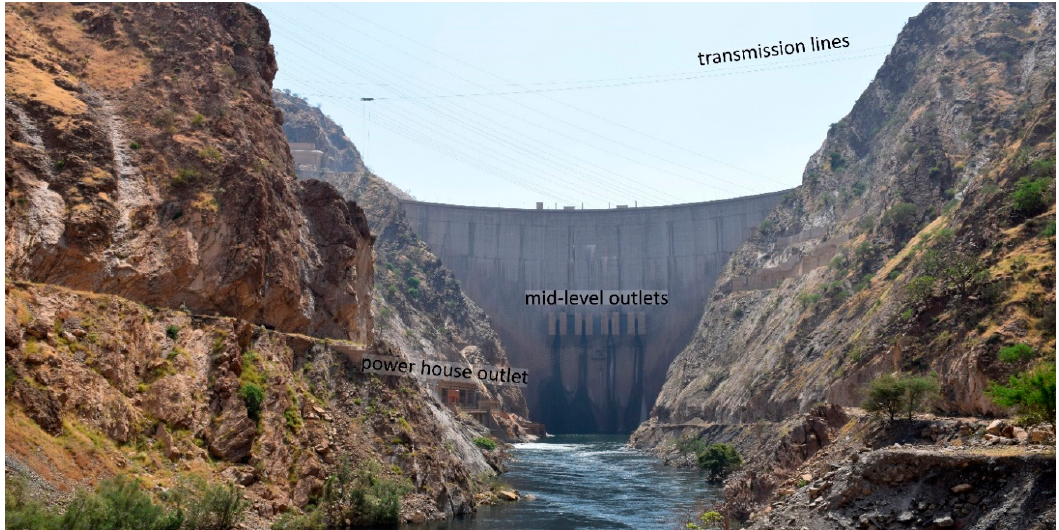
Figure 8. Downstream view on the 188 m high Tekeze arch dam with its four mid-level outlets and transmission lines crossing the narrow gorge (Photo: 15 October 2018).